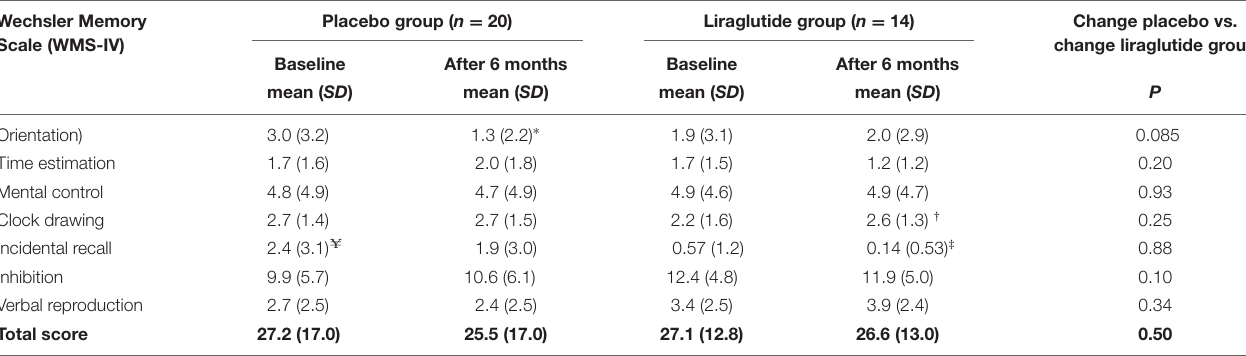
change liraglutide group